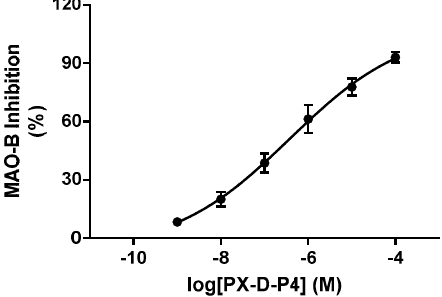
Figure 5. Inhibition curve of compound PX-D-P4 on MAO-B activity. The IC 50 value was calculated by fitting the data, using nonlinear least-squares regression analysis. Results are expressed as the percentage of the MAO-B activity inhibition. The meaning of 100% is that MAO-B activity has been inhibited to the lowest activity for converting luminogenic MAO-B substrate to luciferin, which can produce light, and the produced light intensity is near to the level of the substrate absence. The experiments were performed in duplicate and the values are displayed as mean ±